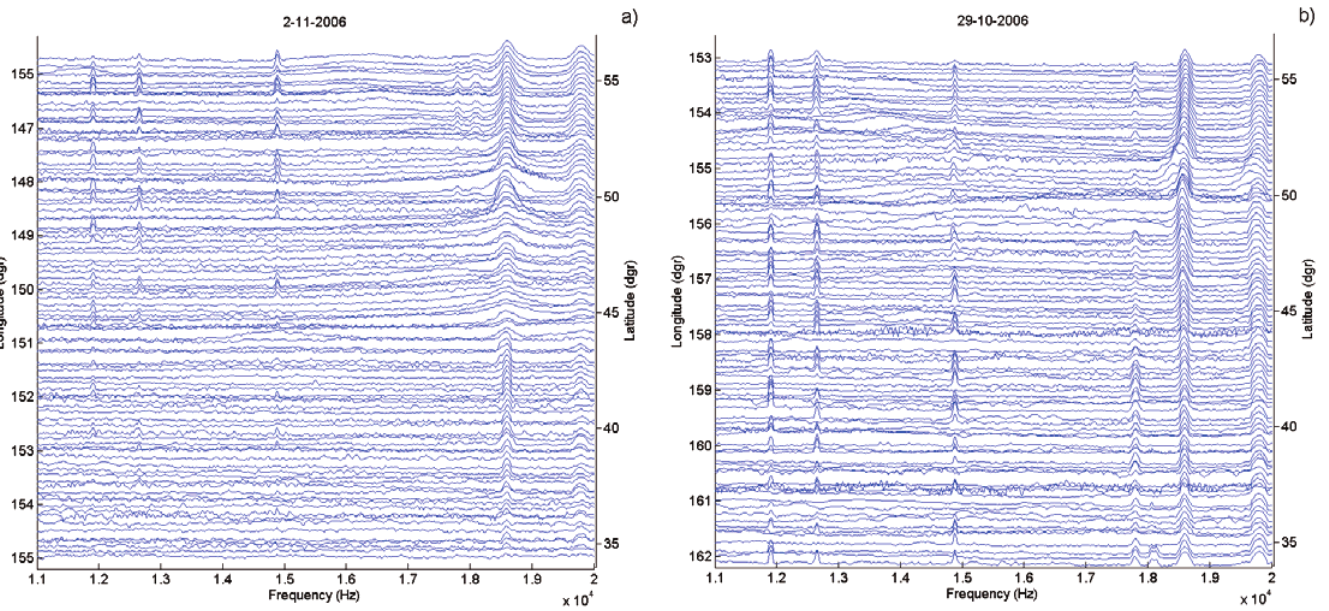
Figure 3. VLF signal variations recorded by the DEMETER satellite along parts of the orbits for the frequency range 11 kHz to 20 kHz. Upper panel: Disturbed day of November 2, 2006. Bottom panel: Quiet day of October 29, 2006. Left Y axis, longitude; right Y axis, latitude, for points of the orbits.